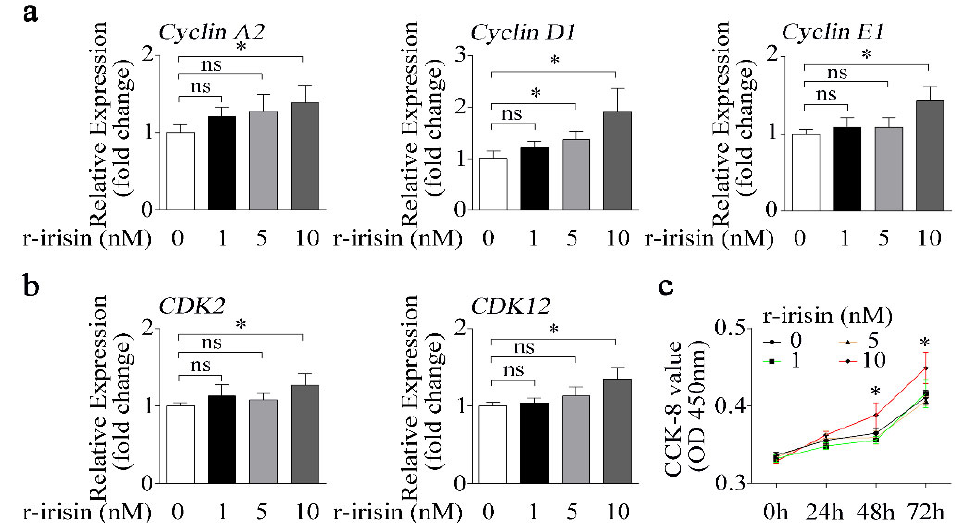
Figure 3. Higher dose of r-irisin promotes primary osteoblast proliferation. ( a ) Real-time PCR analysis of Cyclin A2 , Cyclin D1 , and Cyclin E1 in primary osteoblasts after treatment with a di ff erent dose of either r-irisin or PBS for 48 h; n = 3. ( b ) Real-time PCR analysis of CDK2 and CDK12 in primary osteoblasts after treatment with a di ff erent dose of either r-irisin or PBS for 48 h; n = 3. ( c ) Cell counting kit (CCK-8) was applied to detect proliferation in primary osteoblasts after treatment with a di ff erent dose of either r-irisin or PBS for 0, 24, 48, and 72 h; n = 5. Gapdh was used as the internal control for mRNA. All data are the mean ± SD. Statistical di ff erences between the two groups were determined by the Student’s t- test; * p < 0.05, ns, no significant difference.